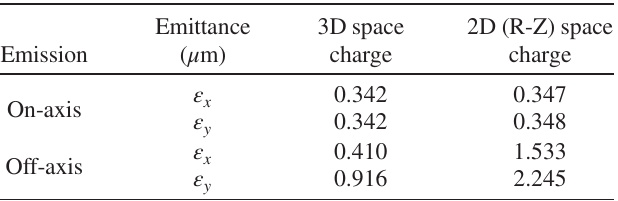
TABLE V. Final transverse emittances obtained using simu- lation with an axisymmetric 2D space charge solver and with a fully 3D space charge solver. The cases of on-axis emission and 2 mm off-axis emission with 250K macroparticles are both listed. The off-axis beam is not corrected. (The dipole correctors are powered